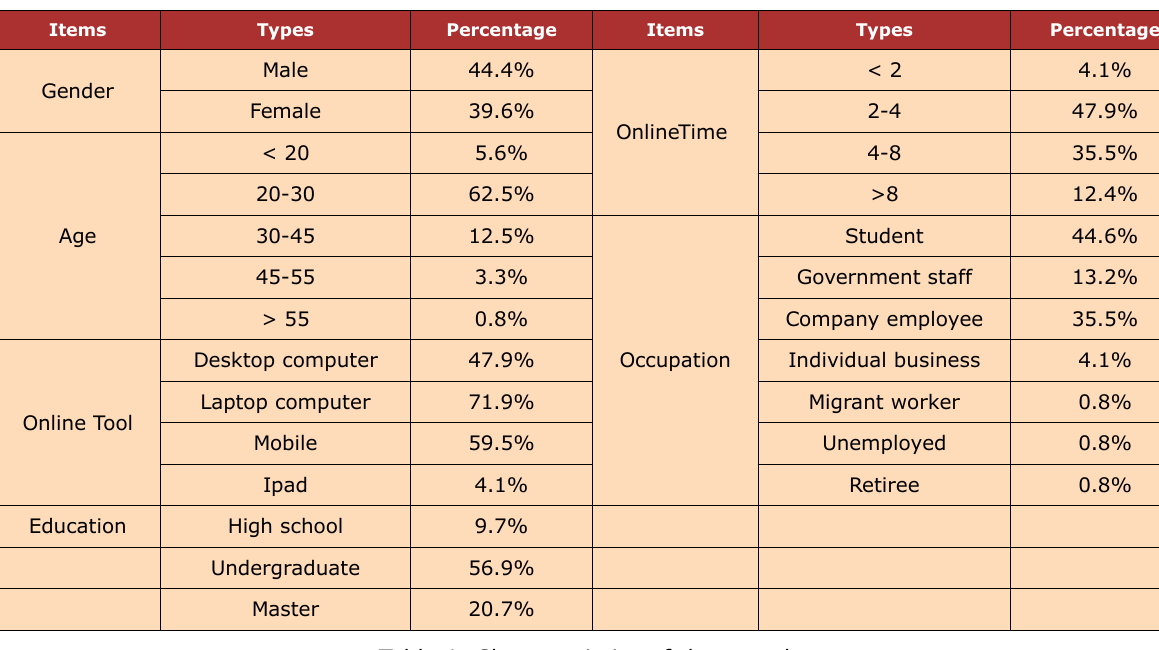
Table 1. Characteristics of the samples